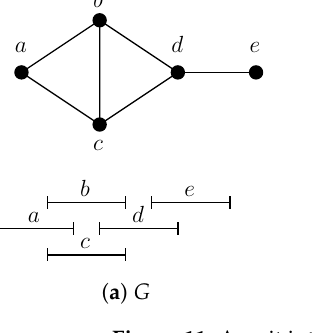
Figure 11. A unit interval G and its twin graph G 1 .